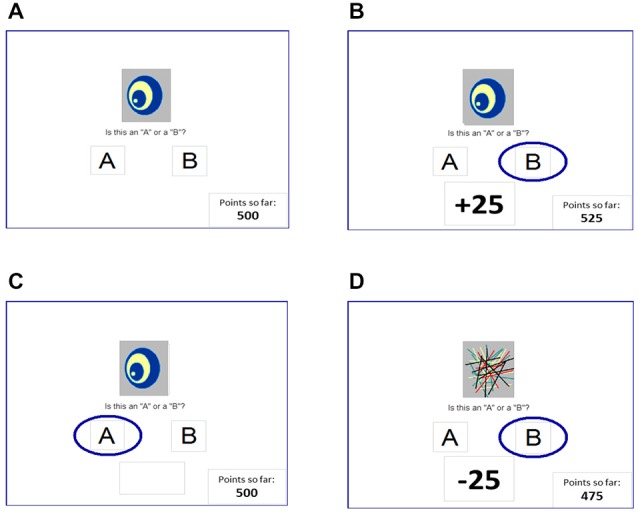
The reward- and punishment-learning task (Bódi et al., 2009). (A) On each trial, a stimulus appears and the subject guesses whether this stimulus belongs to category “A” or category “B.” For two stimuli, correct responses are rewarded (B) but incorrect responses receive no feedback (C); and for the other two stimuli, incorrect responses are punished (D) but correct responses receive no feedback. In Experiment 1, reward-based and punishment-based trials were interleaved, as in the original Bódi et al. (2009) study; in Experiment 2, reward-based and punishment-based trials were presented in separate blocks.